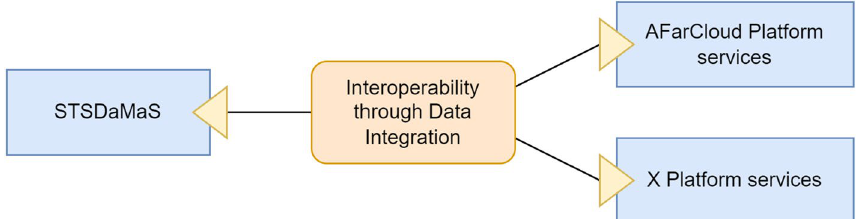
Fig. 4 Interoperability with different platform services through